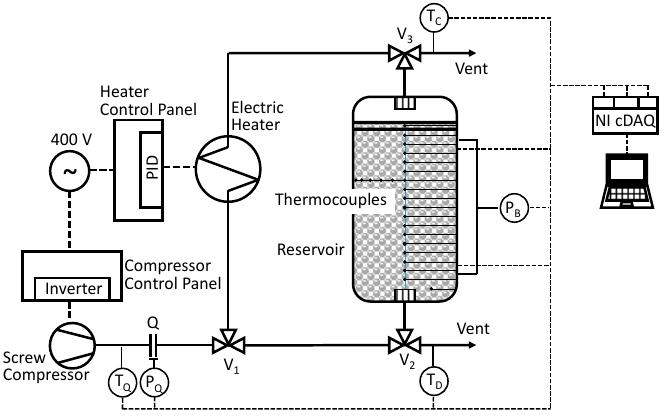
Figure 1. Simplified schematic of the test rig.